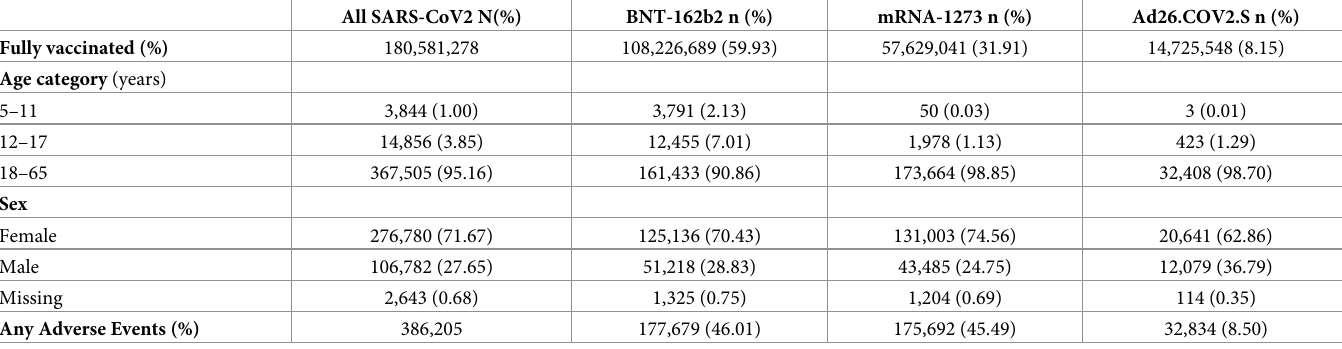
Table 1. Descriptive characteristics of the